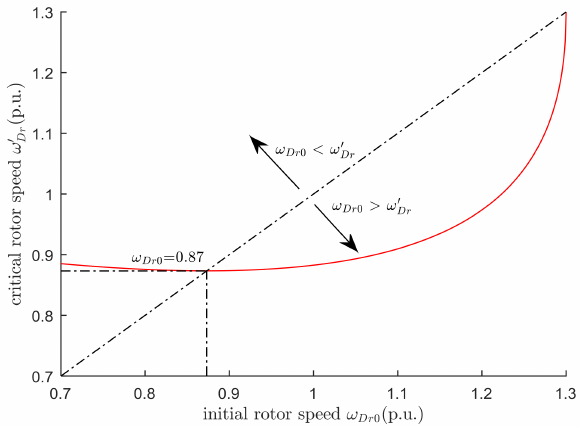
Figure 9. Critical rotor speed of DFIG changing with the initial rotor speed.